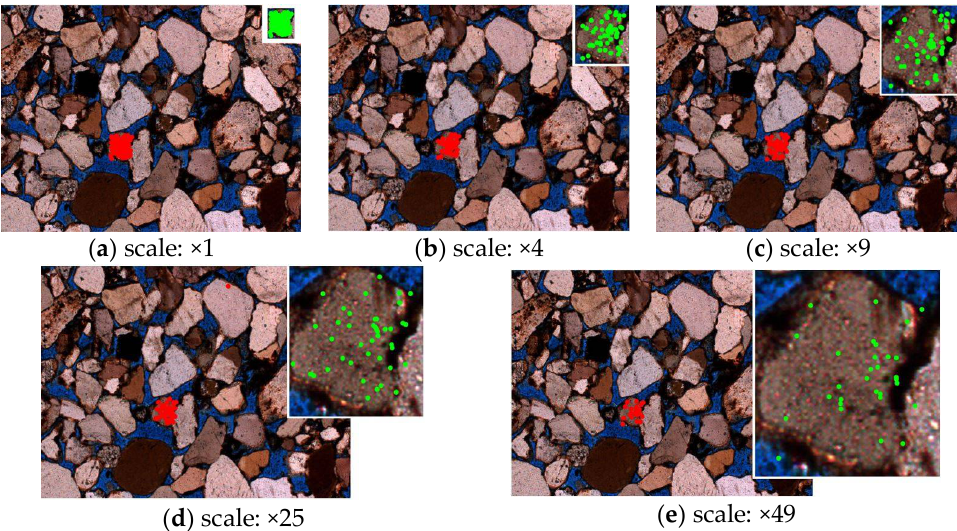
Figure 5. Effects of the detection of interest points using computer-scaled query image (green points) and original image (red points) obtained for the SURF method, sandstone from Solec. Table 4. The number of MIPs for the computer-scaled query image (the Figure 5 case).